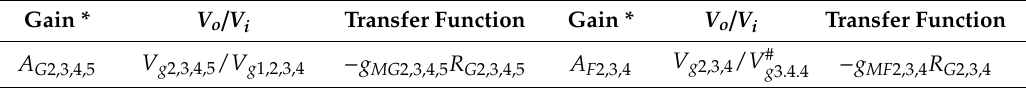
Figure 5. ( a ) Simplified and ( b ) transistor-level schematic of the proposed DVGTIA gain stage for both designs 1 and 2 together with the source follower bu ff er. Table 2. Table of gain functions in DVGTIA gain